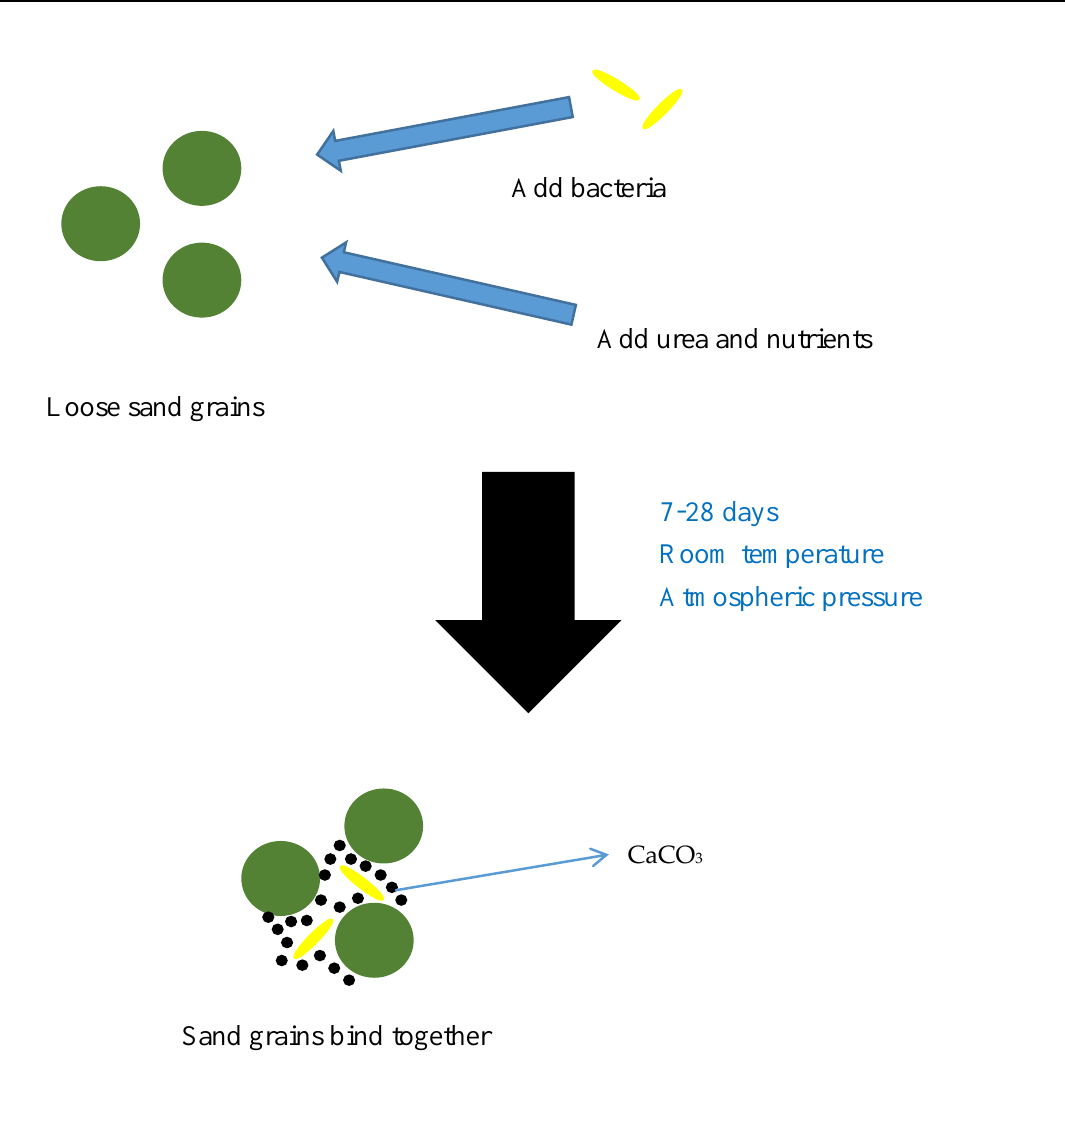
Figure 1. Schematic diagram of the microbially induced calcium carbonate precipitation (MICP) process for biocementation of sand.